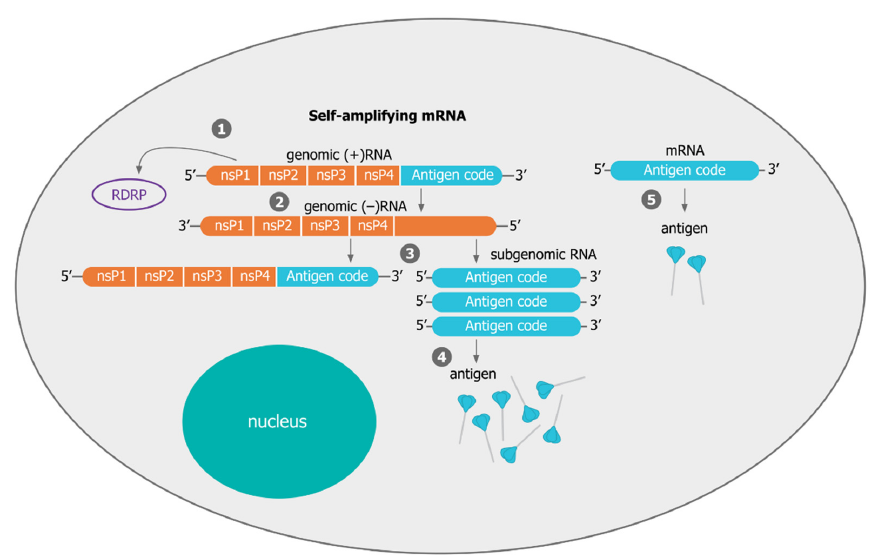
Figure 5. Mechanism of self-amplifying mRNA. ( 1 ) Following delivery to the cytoplasm, translation of the saRNA produces the non-structural proteins 1–4 (nsP 1–4) that form the (RDRP). ( 2 ) RDRP is responsible for replication of the saRNA producing copies of the saRNA. Multiple copies of the subgenomic RNA ( 3 ) are hence produced from each saRNA originally delivered. This leads to translation of many more copies of the antigen ( 4 ) when compared to a non-amplifying RNA ( 5 ).